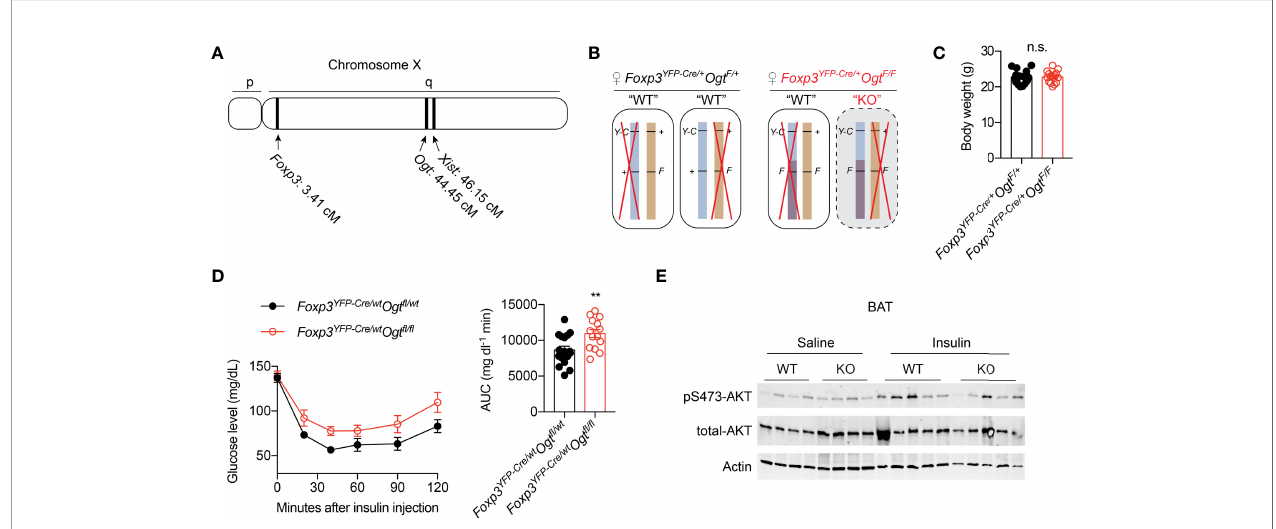
FIGURE 1 | Mosaic OGT-de fi ciency in Treg cells decreases insulin sensitivity. (A) Chromosome positions of mouse Foxp3 and Ogt genes. The Xist gene is shown for reference. cM, centimorgan. (B) Schematic view of allele combinations of the Foxp3 and Ogt genes in Foxp3 YFP-Cre/wt Ogt F/+ and Foxp3 YFP-Cre/wt Ogt F/F female mice. Y-C , YFP-Cre ; F , fl oxed; +, wildtype (wt). Red “ X ” indicates random inactivation of one of the two X chromosomes. (C) Body weight of 3-month-old, NC-fed Foxp3 YFP-Cre/wt Ogt F/+ (n = 18) and Foxp3 YFP-Cre/wt Ogt F/F (n = 15) female mice. (D) Insulin tolerance test of 3-month-old, NC-fed Foxp3 YFP-Cre/wt Ogt F/+ (n = 17) and Foxp3 YFP-Cre/wt Ogt F/F (n = 14) female mice. Area under curve (AUC) is shown to the right. (E) pS473-Akt and total-Akt immunoblotting of BAT protein lysates from Foxp3 YFP-Cre/wt Ogt F/+ and Foxp3 YFP-Cre/wt Ogt F/F female mice treated with saline or insulin for 30 min. Data are presented as mean ± SEM. n.s., not signi fi cant; **, p < 0.01 by unpaired student ’ s